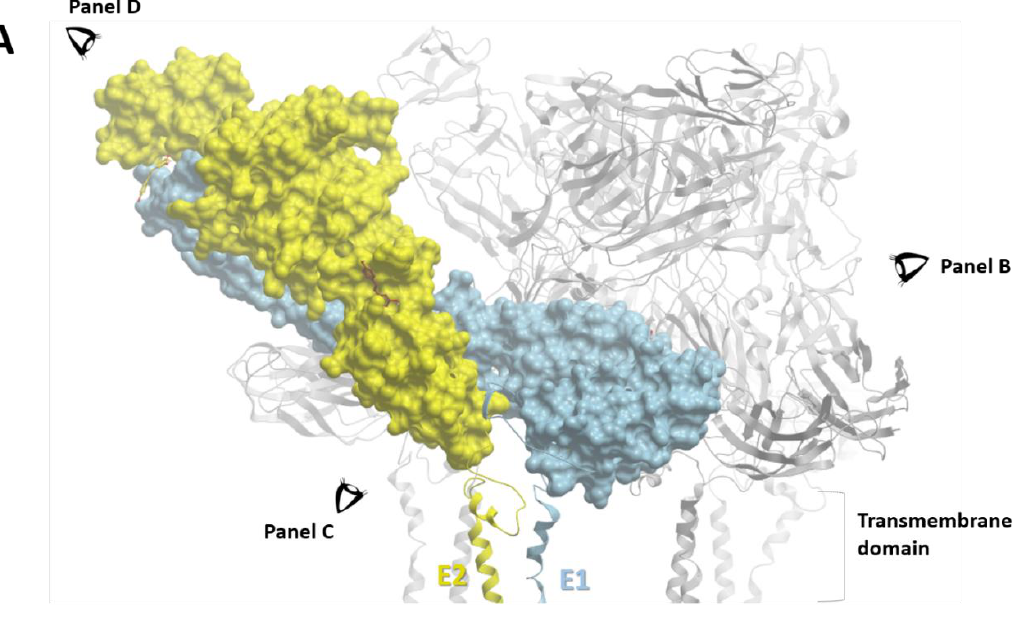
Figure 4. Interaction between resveratrol and VEEV envelope glycoproteins. ( A ) Overview of VEEV E1 and E2 proteins, indicating the viewing angles corresponding to the following panel ( B – D ). Red arrows indicate the positions of resveratrol, and E1 and E2 are labeled in indigo and gold, respectively. ( E ) Viral attachment and entry were determined by quantifying the VEEV RNA inside cells at 16 h.p.i. in the presence or absence of resveratrol. ** p < 0.01 compared to viral control (VC) by one-way